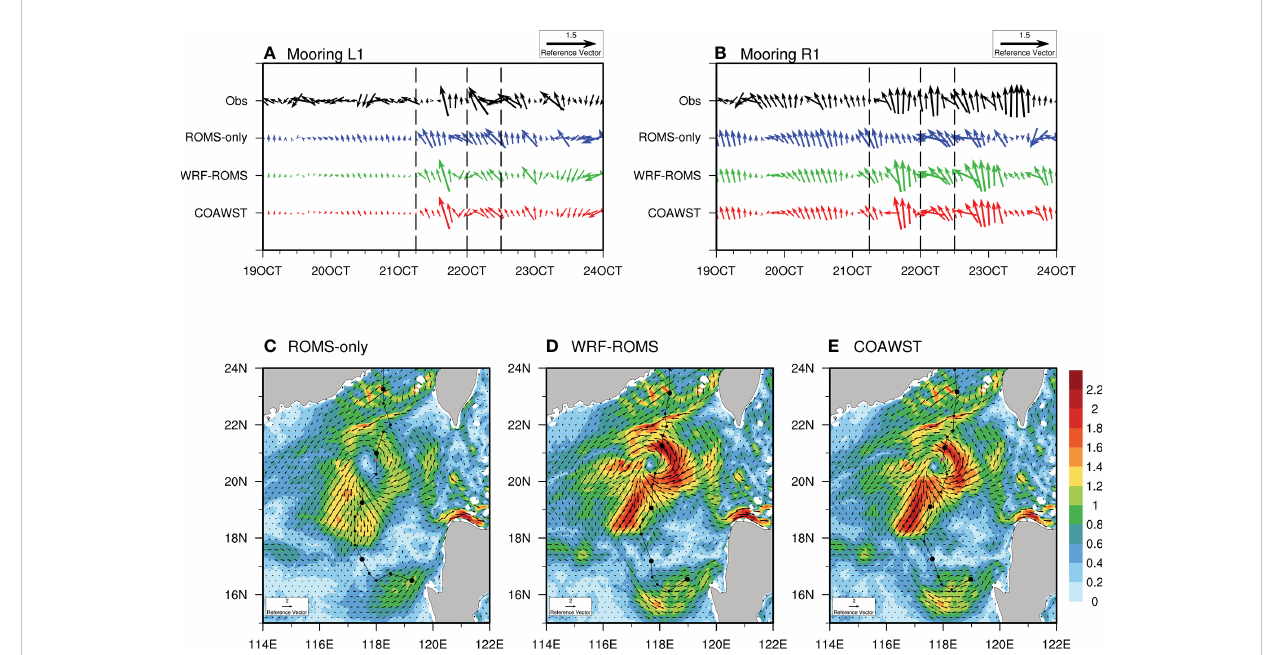
FIGURE 8 (A, B) Comparison of ocean current direction at mooring L1 and R1 in the upper ocean (50 – 80 m) averaged. Vertical dashed lines indicate the times during Megi ’ s approaching, arriving, and passing over. (C – E) Comparison of simulated ocean currents of ROMS-only (C) , WRF-ROMS (D) , and COAWST (E) at 18 UTC 21 Oct. The track information is the same as Figure 3, and the tropical cyclone center at this time is marked with magenta dots.